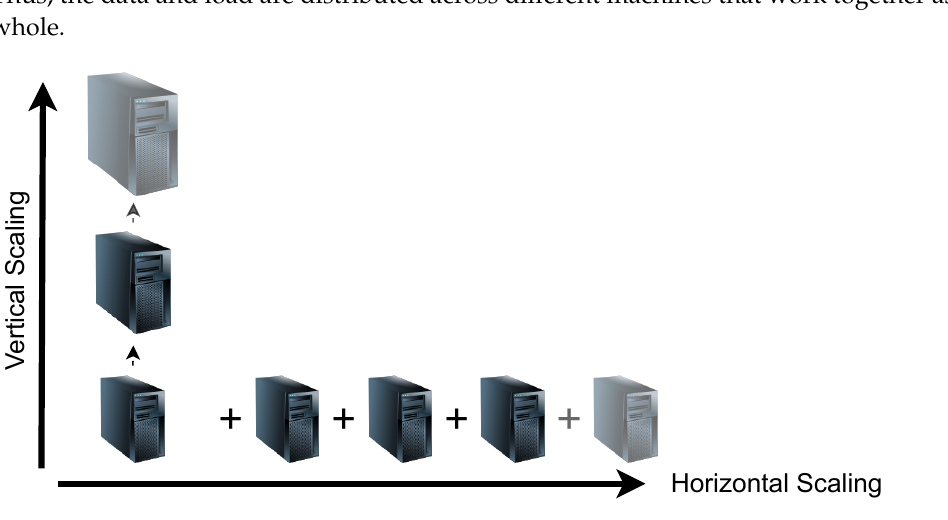
Figure 2. Vertical and horizontal scaling representation. The vertical axis represents the hardware upgrade or replacement, while the horizontal one represents the addition of further